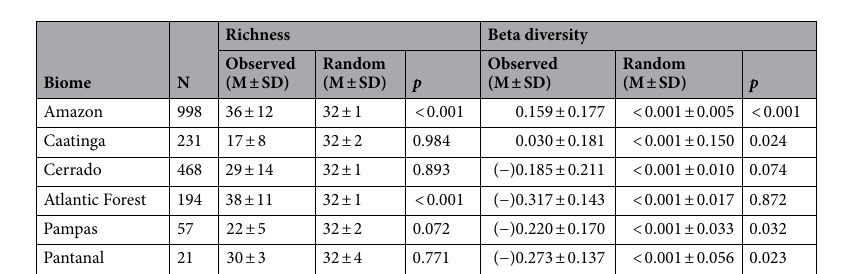
Table 2. Random and observed mean (M) and standard deviation (SD) values of Gerromorpha richness and total beta diversity in Brazilian biomes. N—number of observed cells in each biome; p—significance value according to the Monte Carlo randomization